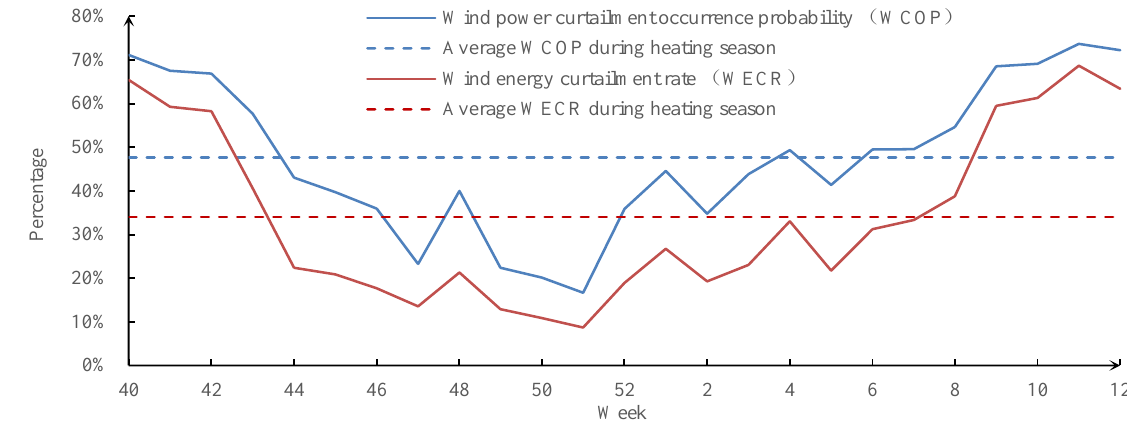
Figure 9. The weekly wind power curtailment occurrence probability (WCOP) and wind energy curtailment rate (WECR) during heat season without TED.